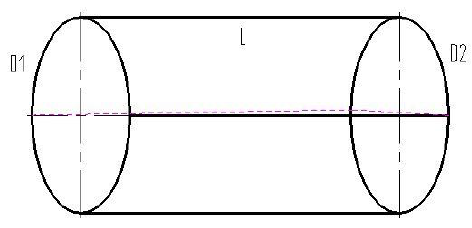
Figure 2. Gatling gun’s barrels.